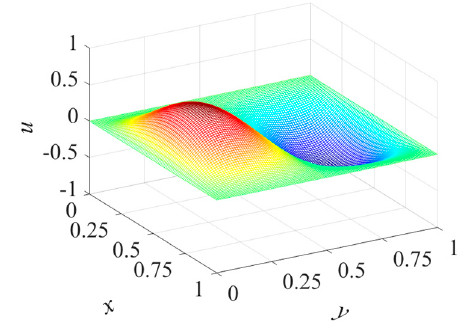
The essential boundary was used and determined by the exact solution. The parameters were chosen to be and When using 21 × 21 node distributions, the 3D surfaces of the solution obtained by the EFG, VMEFG and DS-GIEFG methods are, respectively, shown in Figure 6a–c, and the corresponding exact solution is plotted in Figure 6d. The penalty factor and scalar con- stant of influence domain in the EFG and VMEFG methods are 5 10 α= and , respectively. The corresponding snapshots of the solutions of the DS-GIEFG method on the fields of lines x = 0.1, 0.2,  , 0.9 are listed in Figure 7. Additionally, the absolute errors of the DS-GIEFG and VMEFG methods on the whole field are shown in Figure 8. It can be seen from Figure 6a that the solution of the EFG method is unstable, and there is a non- physical oscillation for the diffusion convection problem with a very small diffusion coef- ficient. Figure 6 shows that both VMEFG and DS-GIEFG methods can obtain stable nu- merical solutions for small diffusion coefficients. Figure 8 also shows that the DS-GIEFG method can have higher calculation accuracy than the VMEFG method.